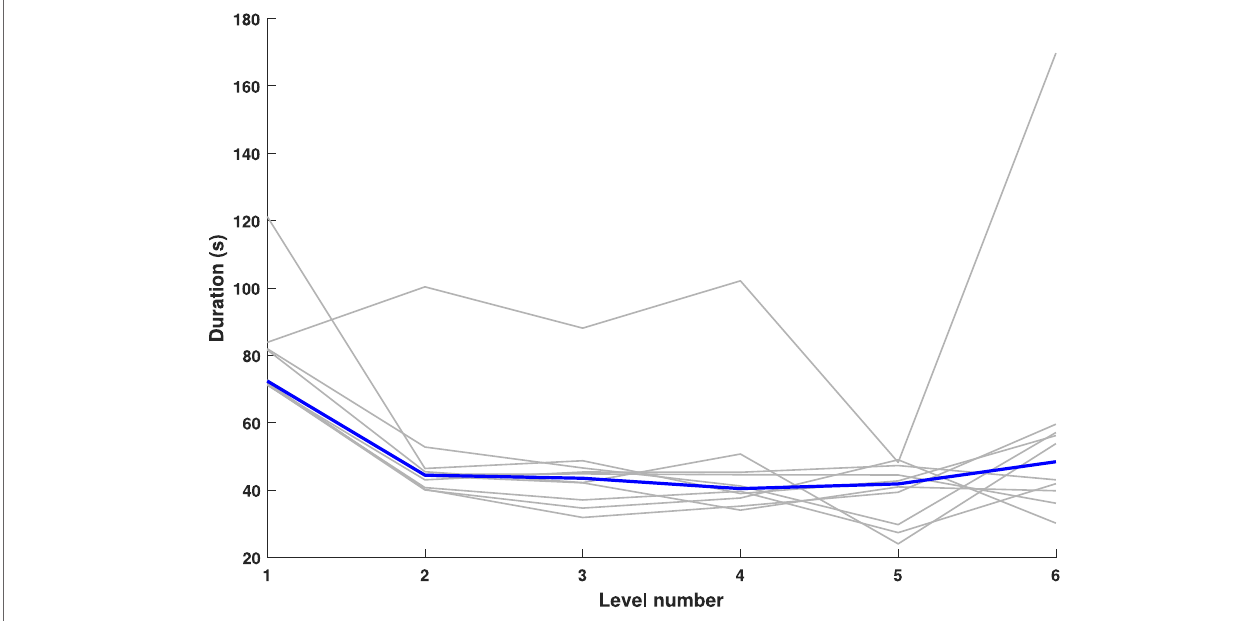
FigUre 3 | Level duration (in seconds) per participant. The gray curves represent individual data. The blue curve shows the median across